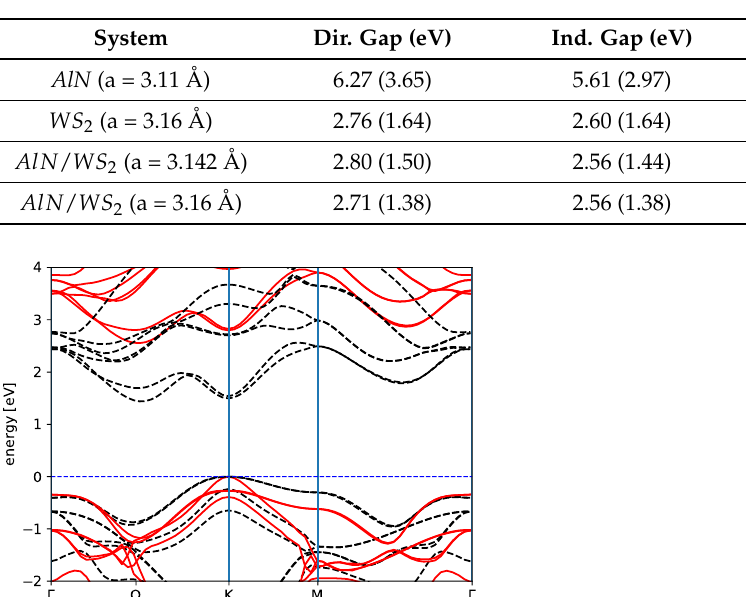
Table 2. Direct K-K and indirect K-Q band gaps for the three system at the G 0 W 0 level. DFT results are given in parentheses. E b is the binding energy of the lowest bright exciton. The third row of the table refers to the relaxed bilayer, whereas the last row refers to the AlN / WS 2 HT forced to keep the same lattice parameter as the isolated WS 2 .